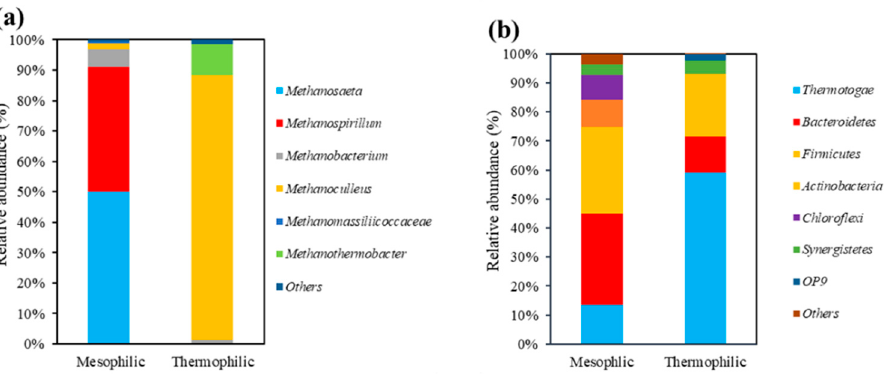
Figure 1. Microorganism composition in mesophilic and thermophilic sludge: ( a ) archaea genus composition, ( b ) bacteria phylum composition.